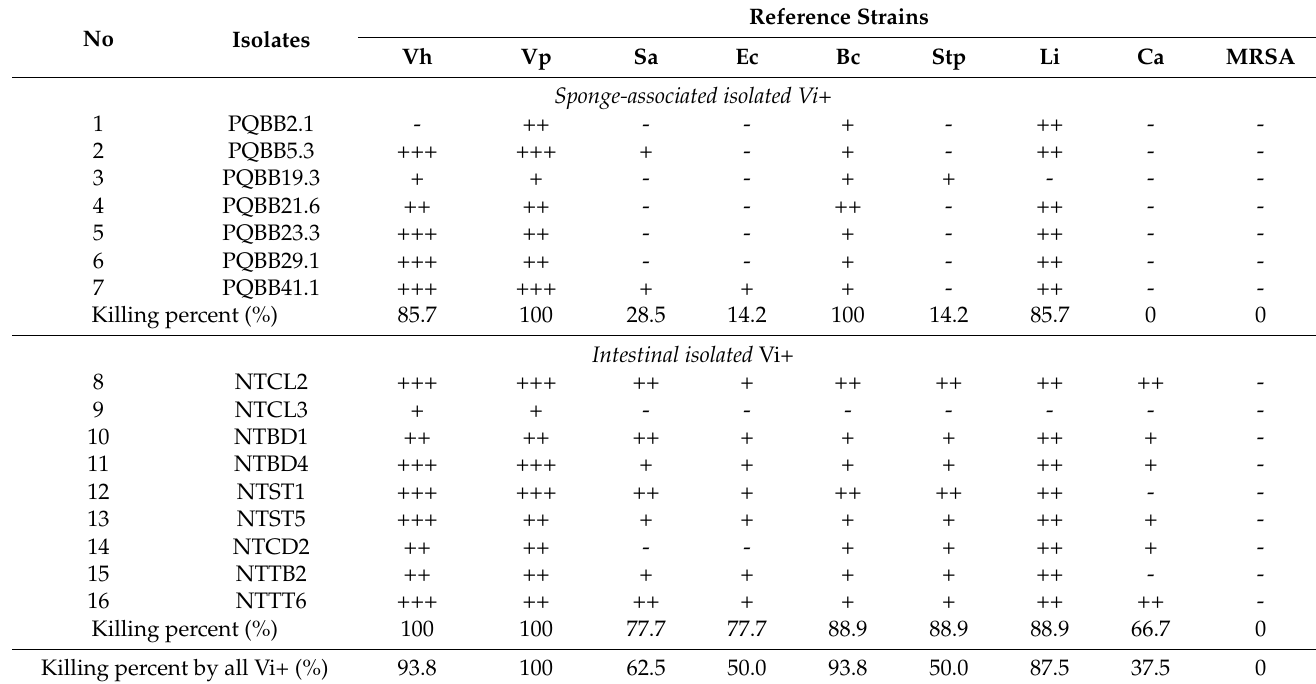
Table 1. Antimicrobial activity of 16 marine isolated Vi+ against foodborne and animal pathogens including V. harveyi ( Vh ), V. parahaemolyticus (Vp), E. coli (Ec), S. typhimurium (Sa), S. aureus (Stp), methicillin-resistant Staphylococcus aureus (MRSA), B. cereus (Bc), L. monocytogenes (Li), C. albicans (Ca). (-) No activity, (+) to (+++) reflects increasing